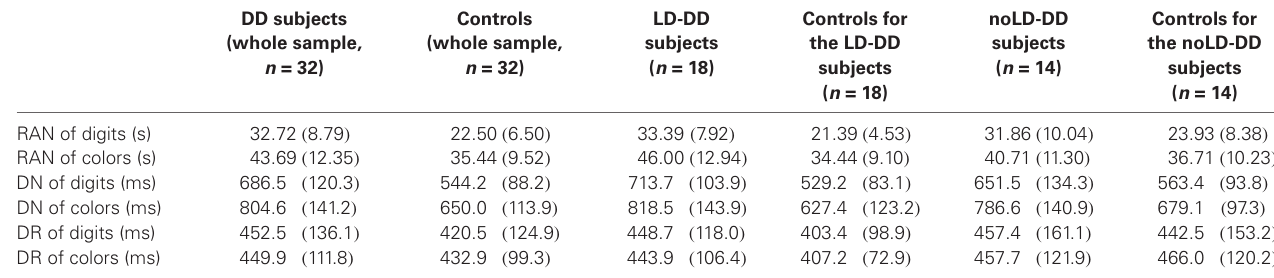
Table 4 | Means and SDs (in brackets) of whole DD sample, of the sub-groups of DD participants with (LD) and without (noLD) a history of language delay and the respective control groups on the three experimental tasks as a function of type of stimulus (digits and colors)